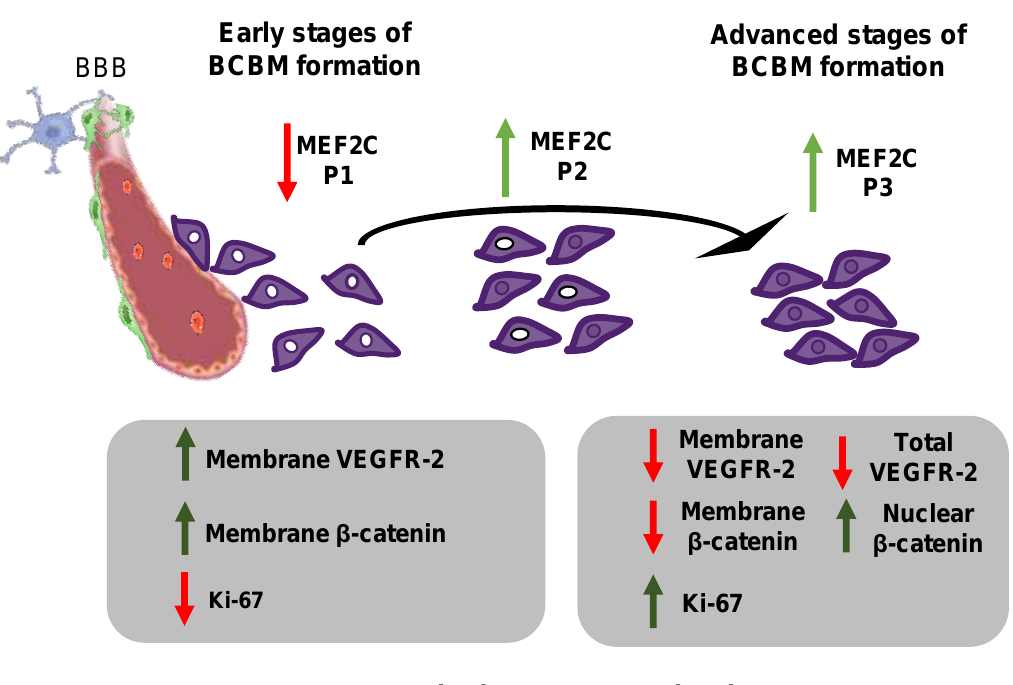
Figure 5. Schematic representation of the proposed interplay between myocyte enhancer factor 2C, vascular endothelial growth factor receptor 2 (kinase domain insert domain receptor, KDR), and β-catenin (CTNNB1) along with the develop- ment of breast cancer brain metastases. In the initial stages of brain metastases, the pattern of myocyte enhancer factor 2C (MEF2C) expression in malignant cells extravasating into the brain and still close to blood–brain barrier (BBB) microvessels is categorized as phenotype (P) 1 (~100% cells with extranuclear location). As metastases progress, the transcription factor progressively translocates into the nucleus giving rise to P2 (~50% cells with extranuclear location and ~50% with overall cell staining), and afterward, to P3 (~100% cells presenting overall cell staining). In parallel, the clear expression of vascular endothelial growth factor receptor 2 (VEGFR-2) at the cell membrane decreases, and an overall loss of the receptor is observed as metastases develop. This is accompanied by a decreased expression of β-catenin in the plasma membrane, which translocates into the nucleus, in line with the role of this molecule in signaling in cancer. Accordingly, an increasing number of Ki-67 positive cells is observed, reflecting the proliferative activity of metastatic cells that accounts for the enlargement of metastases. Collectively, the expression of MEF2C and its translocation into the nucleus is associated with disease severity, which pathogenesis involves VEGFR-2 and β-catenin signaling. Supplementary Materials: The following are available online at www.mdpi.com/xxx/s1, Figure S1: Triple negative breast cancer (TNBC) cells express myocyte enhancer factor 2C (MEF2C), which can be silenced using a specific siRNA; Figure S2: Triple negative breast cancer (TNBC) cells express myocyte enhancer factor 2C (MEF2C) and epithelial (pan Cytokeratin) and mesenchymal (vimentin) markers; Figure S3: Triple negative breast cancer (TNBC) cells express Ki-67, vascular endothelial growth factor receptor-2 (VEGFR-2) and β-catenin . Author Contributions: Conceptualization, M.A.B.; methodology, S.G.; software, S.G., R.M.; valida- tion, L.A.K., J.P., M.A.B.; formal analysis, S.G.; investigation, S.G., M.A.B.; resources, L.A.K., R.M., J.P., M.A.B.; data curation, L.A.K., J.P., M.A.B.; writing—original draft preparation, S.G.; writing— review and editing, L.A.K., R.M., J.P., M.A.B.; visualization, S.G., L.A.K., R.M., J.P., M.A.B.; super- vision, M.A.B.; project administration, M.A.B.; funding acquisition, M.A.B. All authors have read and agreed to the published version of the manuscript. Funding: This research was funded by the Portuguese Foundation for Science and Technology (FCT), I.P., Portugal, grant numbers PTDC/MED-ONC/29402/2017, UIDB/04138/2020 and UIDP/04138/2020.